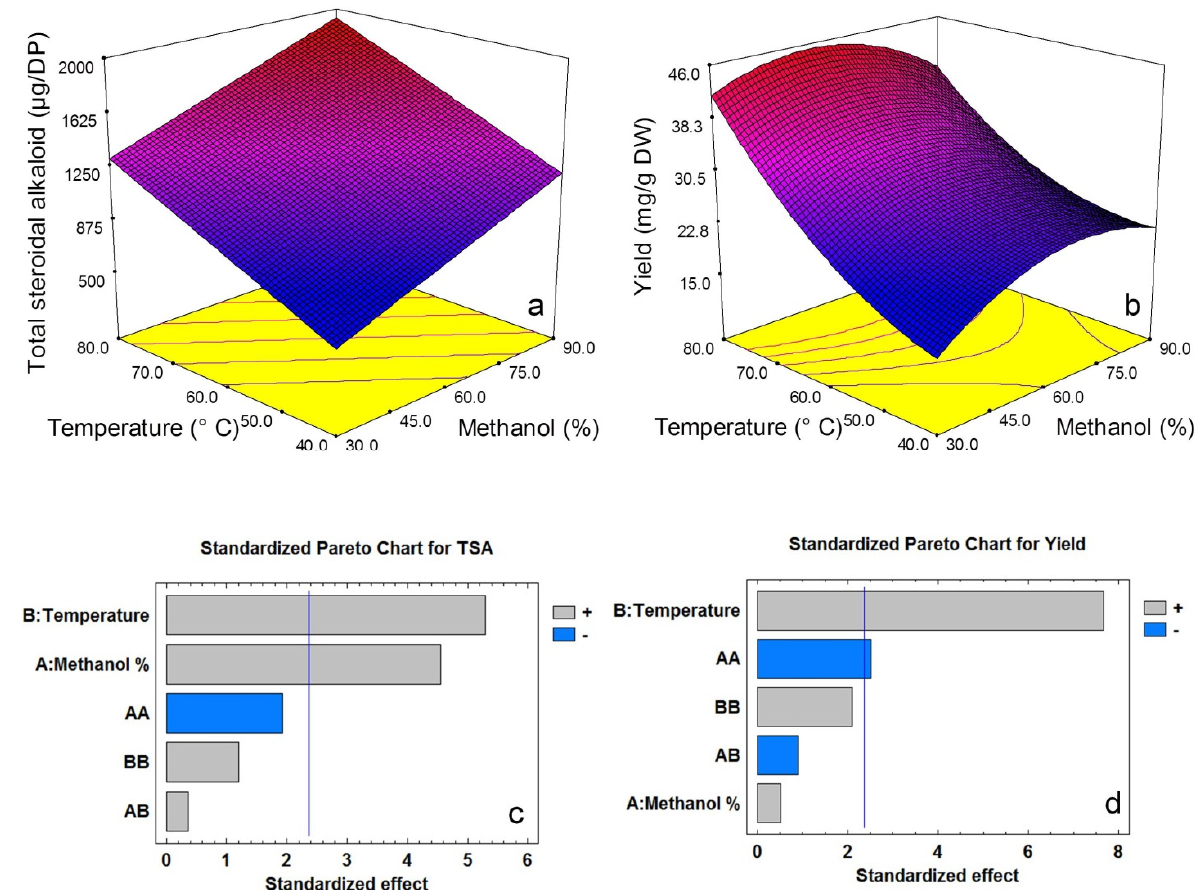
Figure 4. Response surface plots and standardised pareto chart of the effect of temperature and methanol concentration on extraction yield ( a , c ) and total steroidal alkaloids ( b , d ) content in potato peel pressurized liquid extracts. Bars in pareto chart exceeding the vertical line on the graph indicate that the corresponding factor terms are significant ( p <